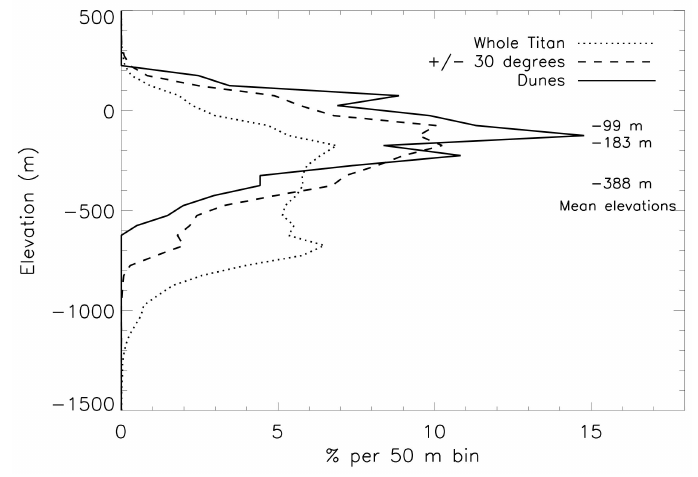
Figure 2. Titan surface topography (m) created by the Cassini Radar Team [20] overlain with dune orientations [22].